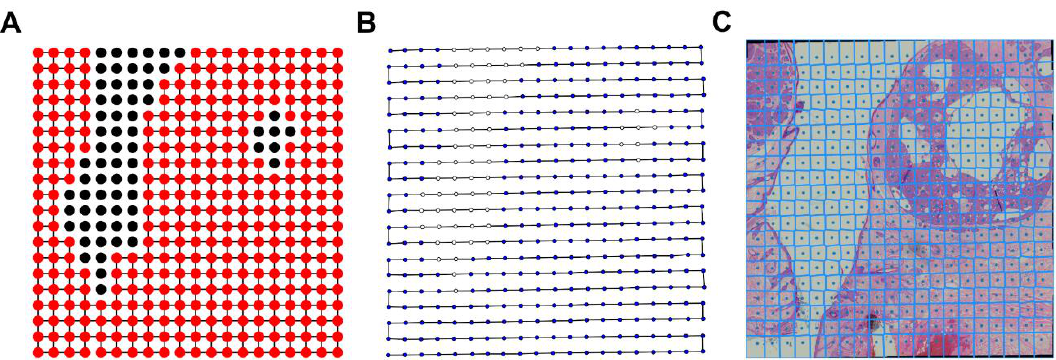
Figure 6. ( A ) Array of 20 × 20 independent images. Red dots represent successful registration between adjacent images, black dots represent unregistered images (background areas without significant features). ( B ) Scanner path. Unregistered images (white dots) are interpolated from the grid of registered images (blue dots). ( C ) Voronoi diagram representing the final stitched result.